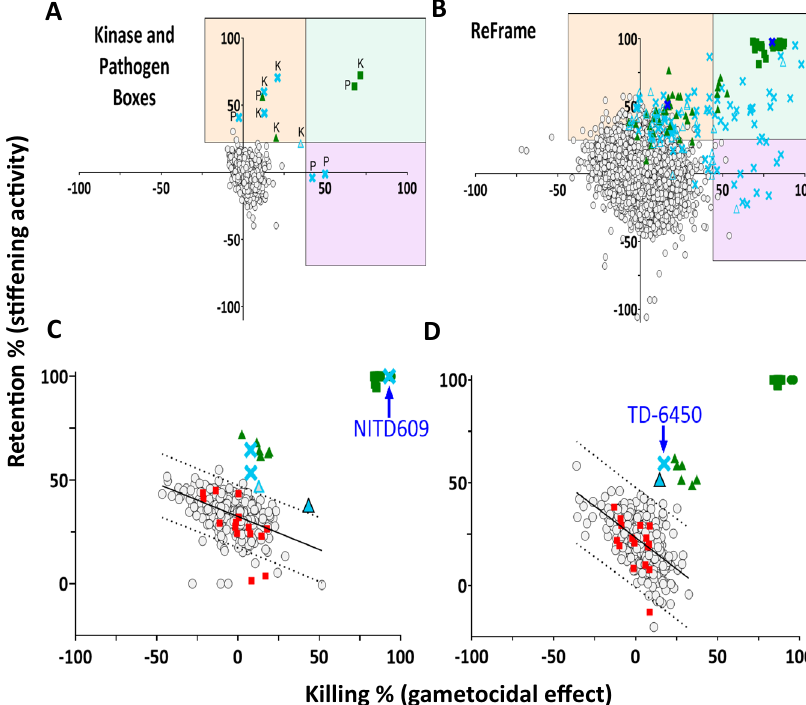
Fig. 2 | Compiled screening results and representative plate analysis. Repre- sentative screening output scatterplots for the speci fi c ( A ) and ReFrame ( B ) libraries,andfor2singleplatesfromtheReFrameprimaryscreening,withNITD609 ( C ) and TD-6450 ( D ) as fi nally selected hits. In panel A, “ K ” refers to Kinase Inhi- bitors Box and “ P ” refers to Pathogen Box. Killing and retention rates are on the x and y axes, respectively. Negative controls (red squares), and positive controls including calyculin A 75nM for stiffening activity (green triangles), Gentian violet